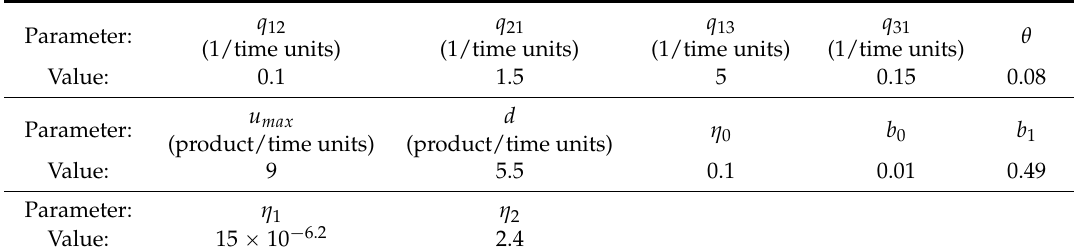
Table 1. Parameters for the numerical example.